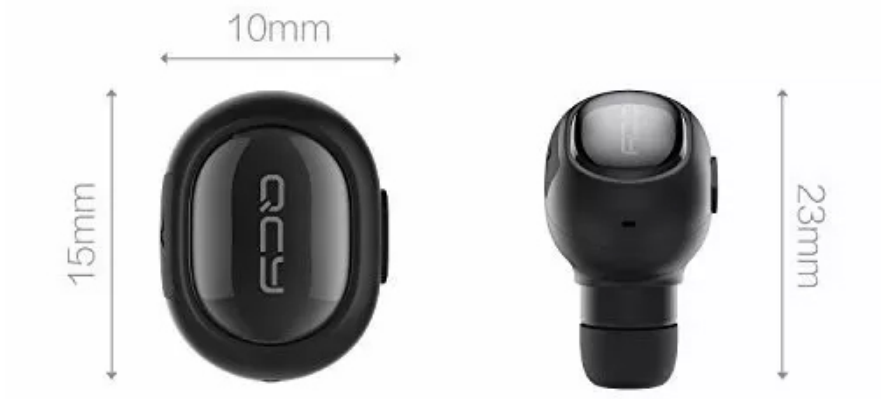
Figure 2. Details of the QCY Q26 Pro Mini Wireless Bluetooth Music Headset . The small hole in the middle of the right view is the microphone.